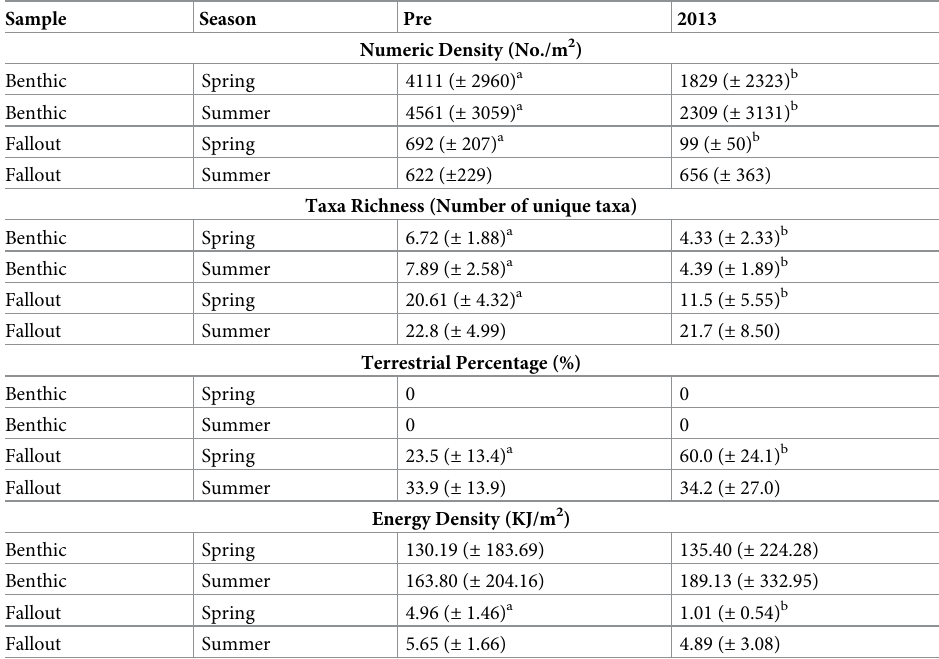
Table 2. Univariate metrics (mean ± 1 SD) from estuary benthic and fallout invertebrate samples.